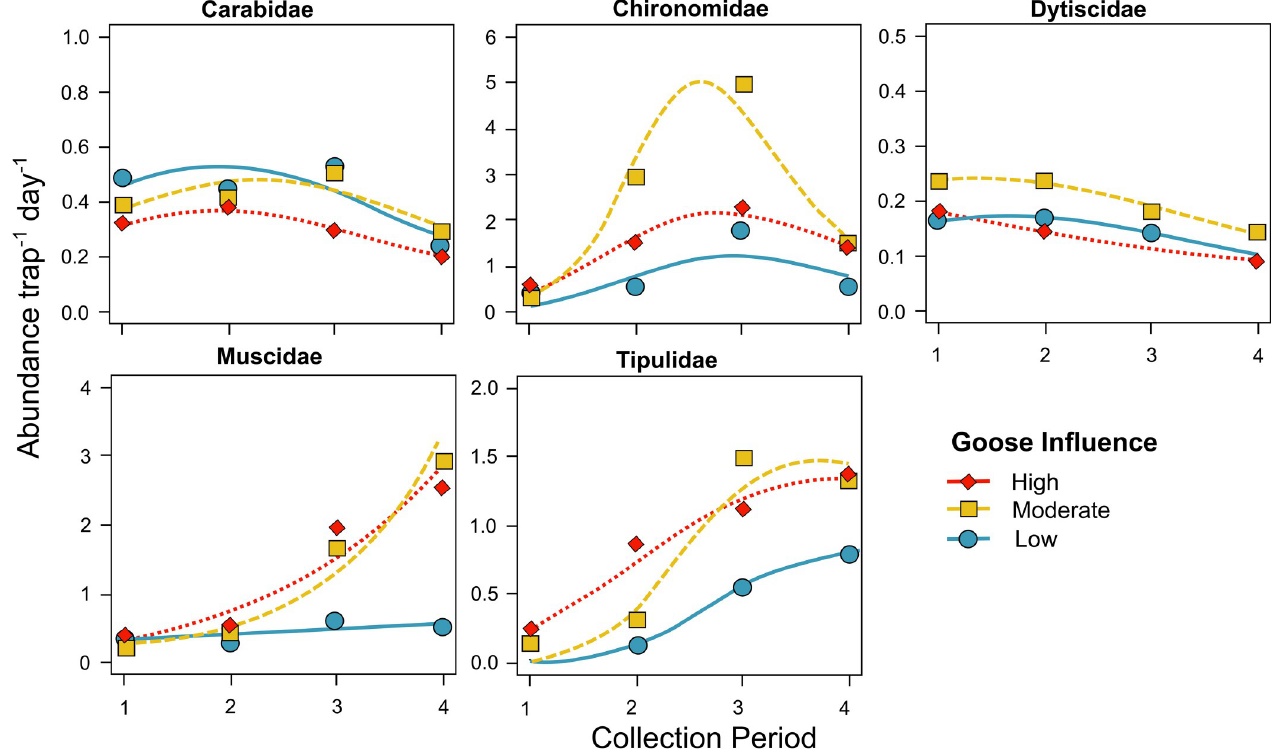
Fig 6. Abundance of dominant invertebrate prey items among study sites and sample periods along with emergence trends from GAMs. Sample collection period dates varied due to environmental factors but typically ranged from 23-Jun to 29-Jun (period 1), 29-Jun to 06-Jul (period 2), 06-Jul to 13-Jul (period 3), and 13-Jul to 21-Jul (period